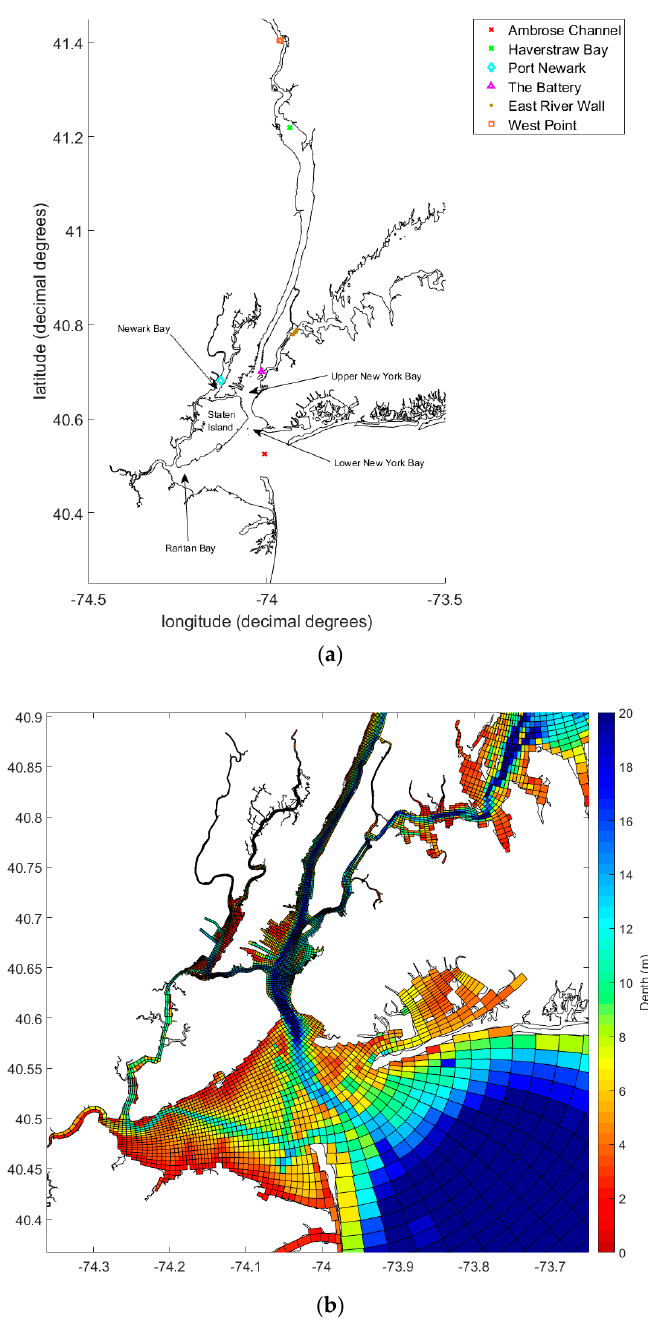
Figure 1. ( a ) Locations and tide gauges referred to in this paper; ( b ) bathymetry of the central New York Harbor (NYH) region used in modeling (as gridded for the numerical model used in this